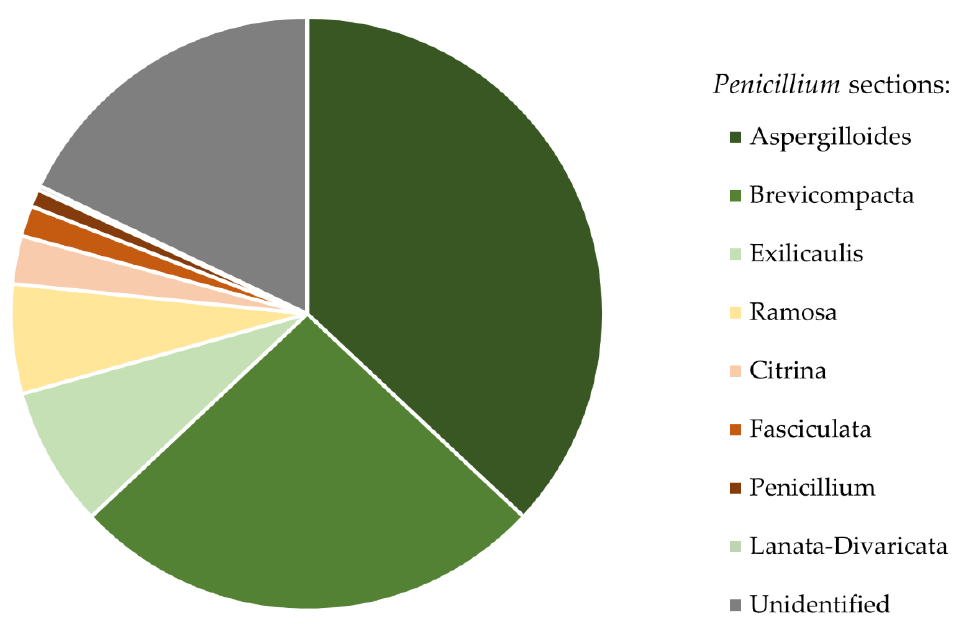
Figure 2. The presence of fungal taxa in F. polyctena nests.